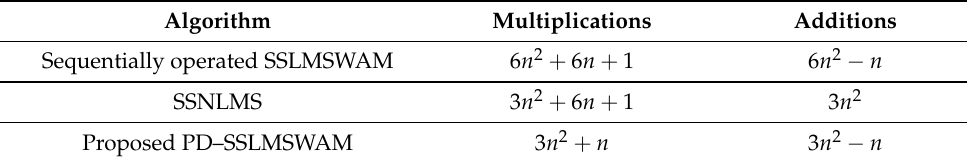
Table 3. Comparison of computational complexity.